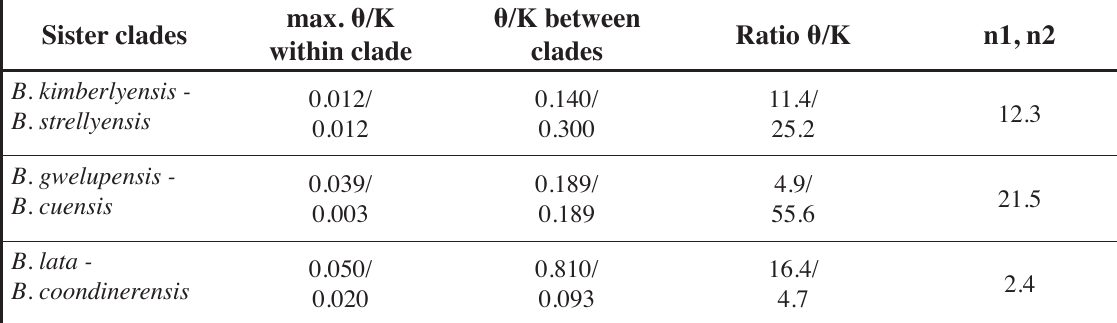
Table 1. results of tests using the 4 x rule in six sibling species in 2 lineages of Bennelongia . max. θ/K θ/K between Sister clades Ratio θ/K n1, within clade clades